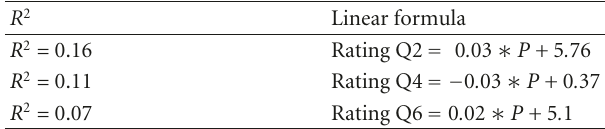
Table 3: Linear regression models for rating Q2, Q4, and Q6.